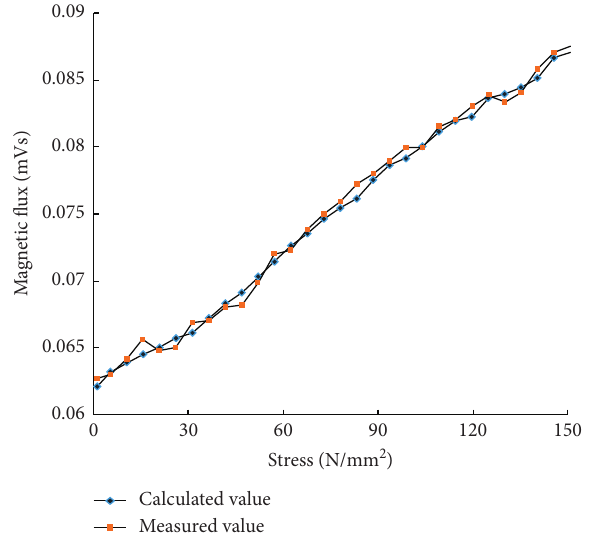
Figure 9: Error curves of calculated magnetic flux and measured value under the same stress